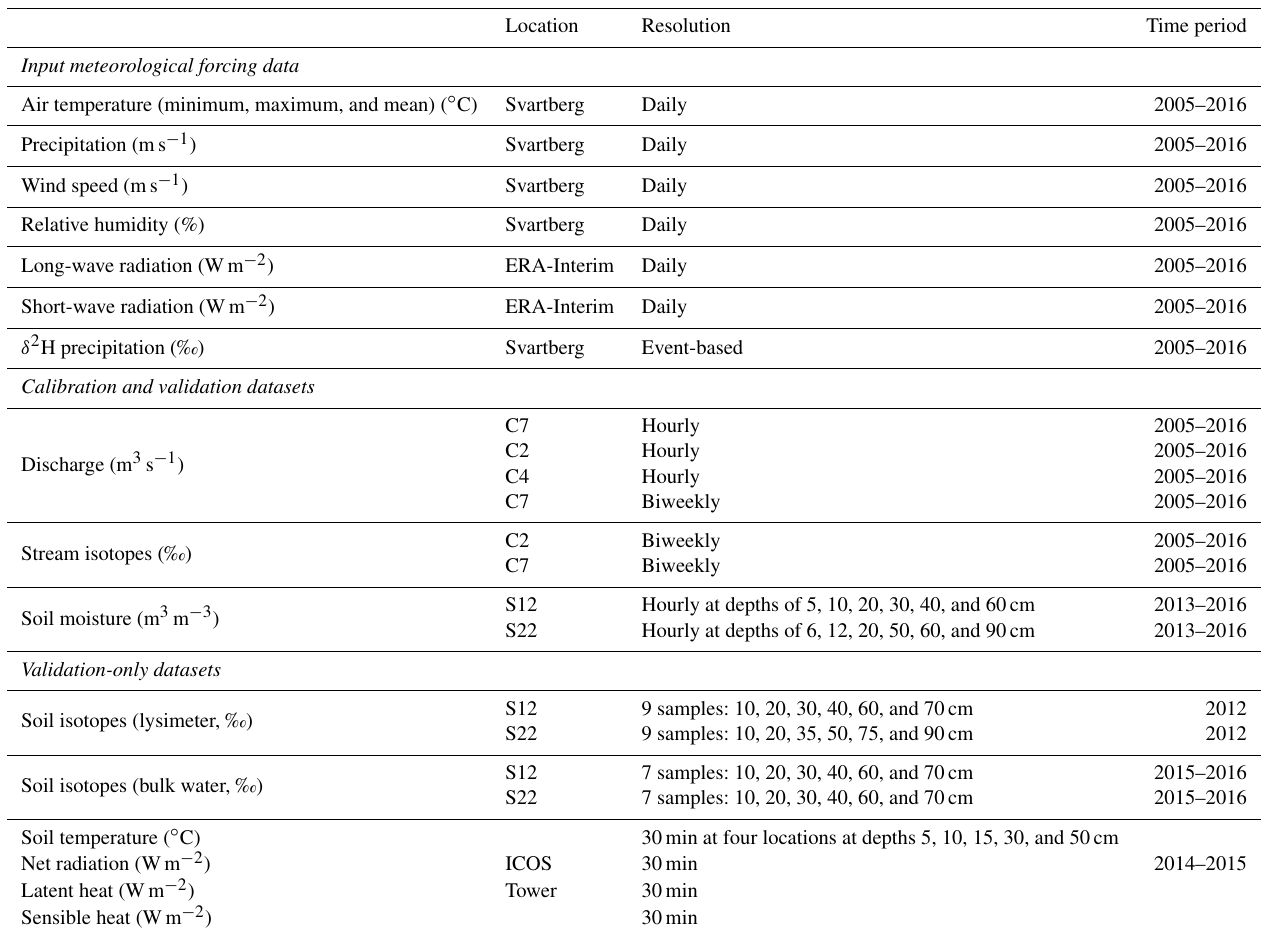
Table 1. Datasets used for forcing, calibration and validation within the Svartberg